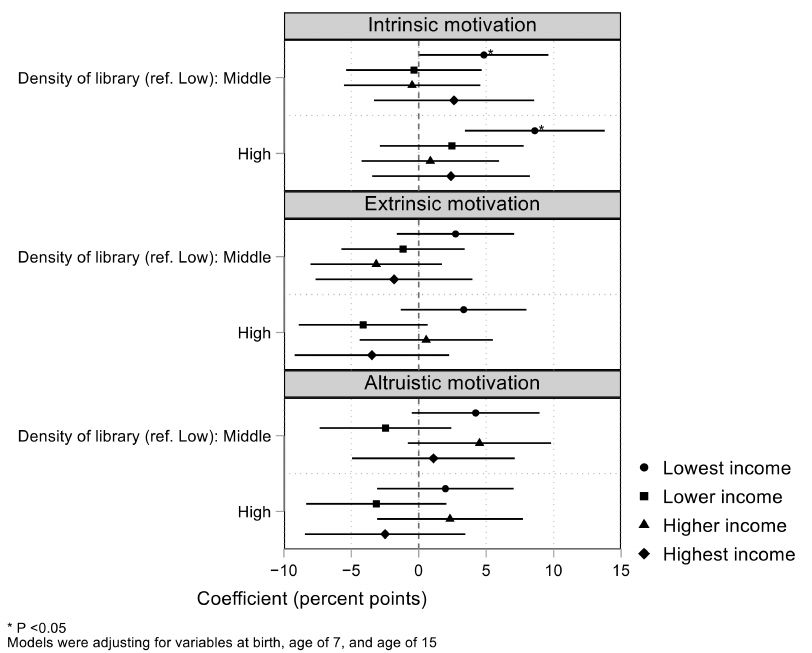
Figure 2. Stratification analysis by equivalent income showing the association of libraries with motivational orientation for the desired occupation.